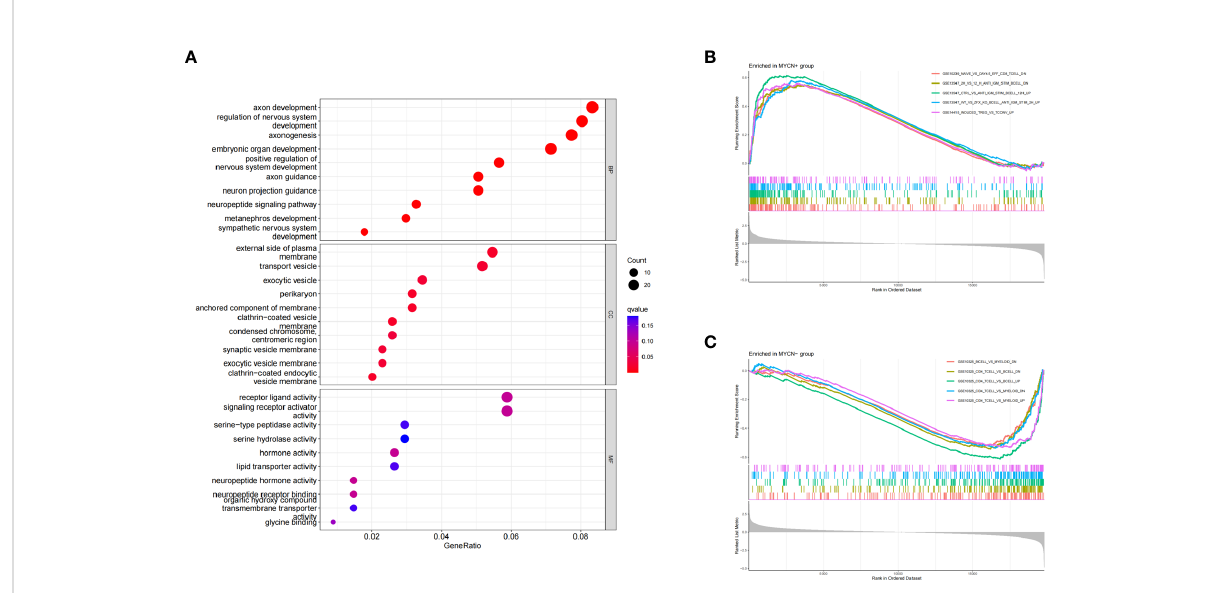
FIGURE 3 GO and GSEA enrichment analyses of DEGs (A) Bubble diagram of GO enrichment analysis of DEGs in MYCN positive NB. (B) GSEA analysis of representative immune-related pathways for all genes in MYCN positive NB. (C) GSEA analysis of representative immune-related pathways for all genes in MYCN negative